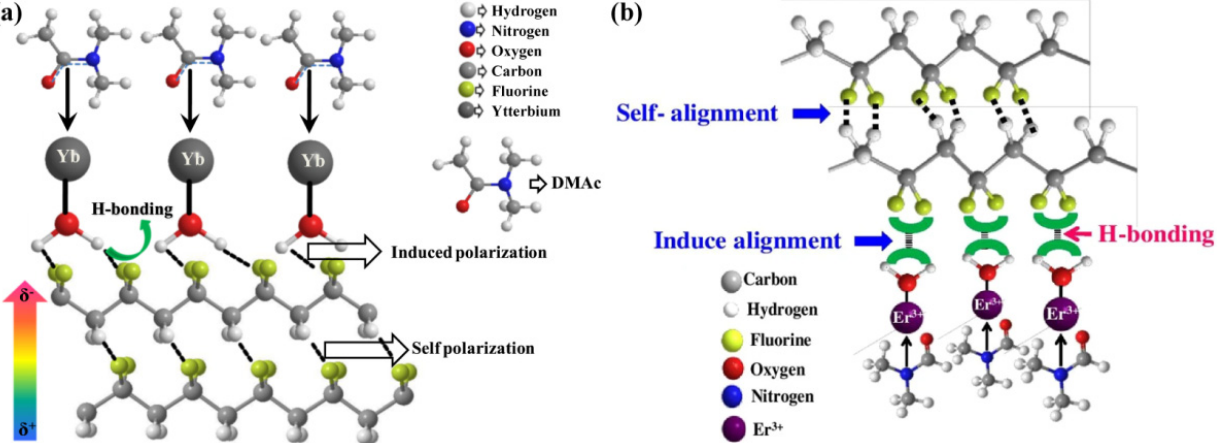
Figure 8. ( a ) The self–polarization process induced by the hydrogen bond interaction between Yb 3+ –PVDF film molecules and the dipolar interaction between Yb 3+ salt and the PVDF chain [74]. ( b ) Schematic of the β phase nucleation process in the Er 3+/ PVDF film [75]. Reproduced with the permission from references [74,75].